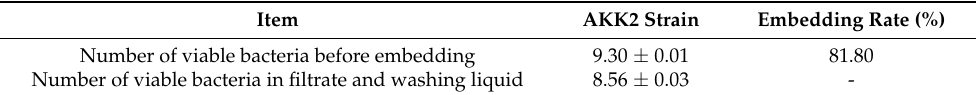
Figure 6. The morphology and characteristics of A. muciniphila strain AKK2 microcapsule. ( a ) morphology of alginate/chitosan encapsulated AKK2 microcapsule. ( b ) preserving stability of unencapsulated AKK2 and ( c ) encapsulated AKK2 at different time points. Table 5. The microcapsule embedding number of bacteria log (CFU/mL).